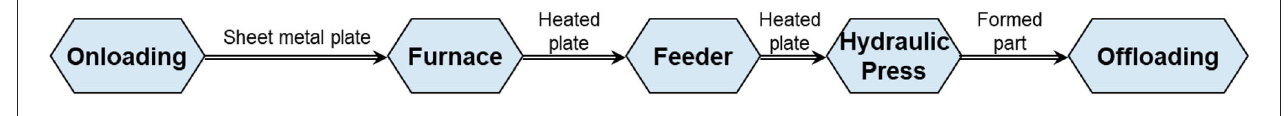
FIGURE 6 | Hot forming press process